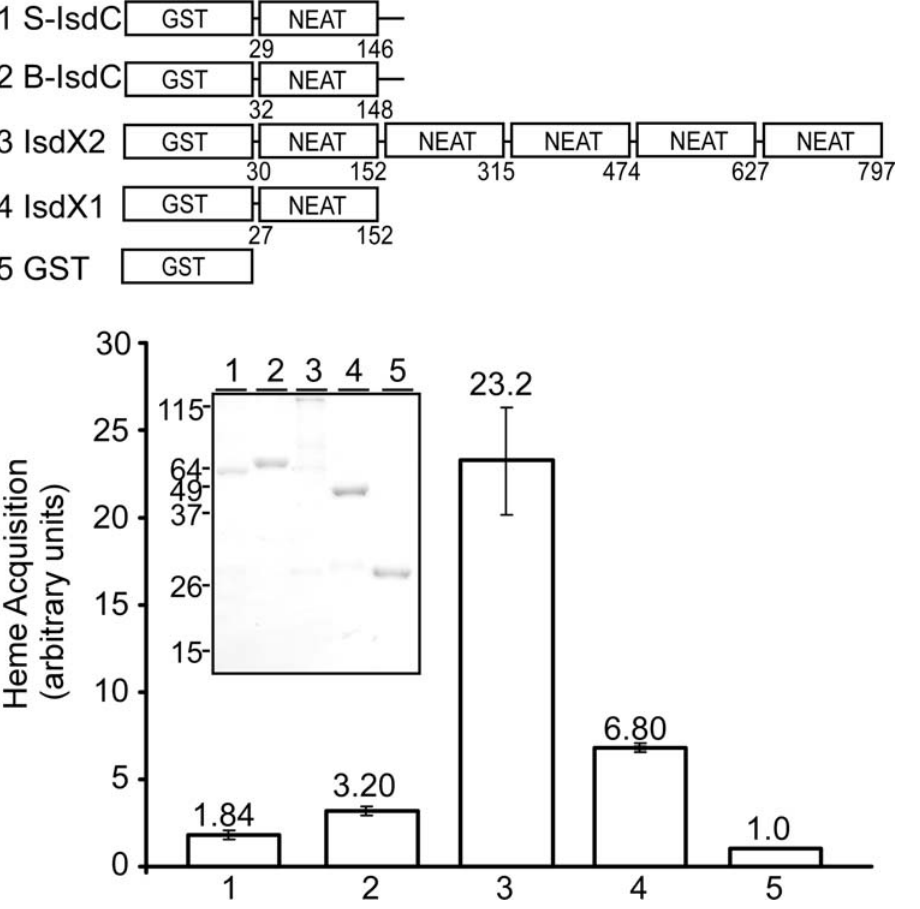
Figure 8. Transfer of heme from hemoglobin to NEAT domain proteins. Purified GST hybrids with (1) S. aureus IsdC (S-IsdC), (2) B. anthracis IsdC (B-IsdC), (3) IsdX2, (4) IsdX1, or (5) GST control were incubated with hemoglobin and heme transfer measured as in Fig. 4. Mean and standard deviation of three independent experiments are recorded. Inset reveals the mobility of purified proteins on Coomassie stained SDS-PAGE.